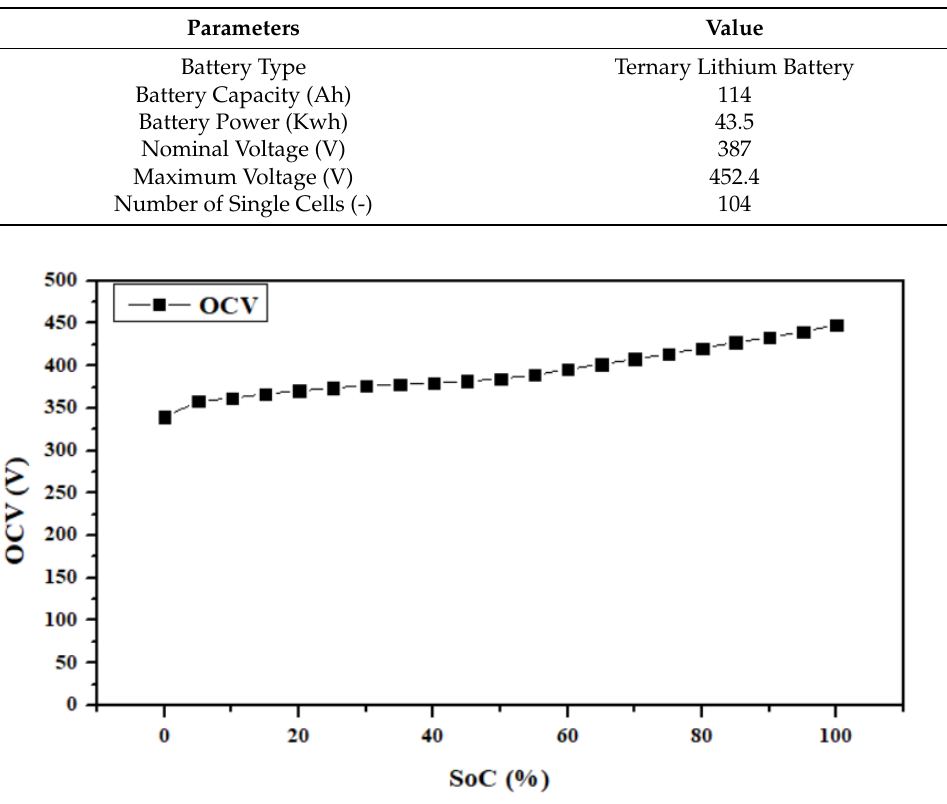
Table 4. Parameters of the range extender.